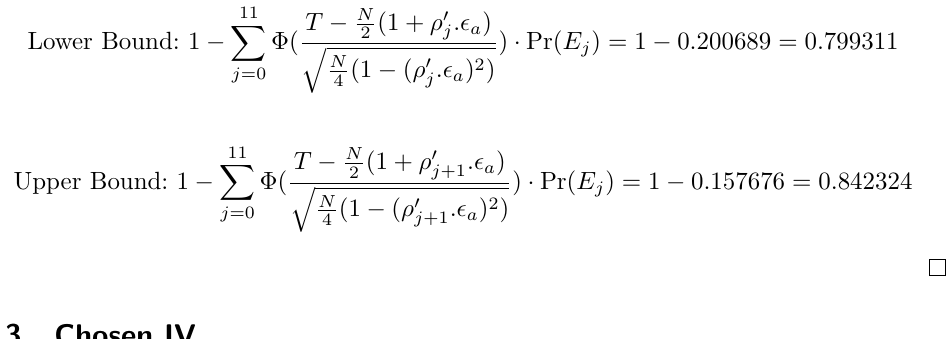
Table 5: ρ ′ values and corresponding Pr( E j ) for the bias distribution using Aumasson’s j approach for ID ∆ (0) [13] and OD ∆ (3) [0] after 3 13 11